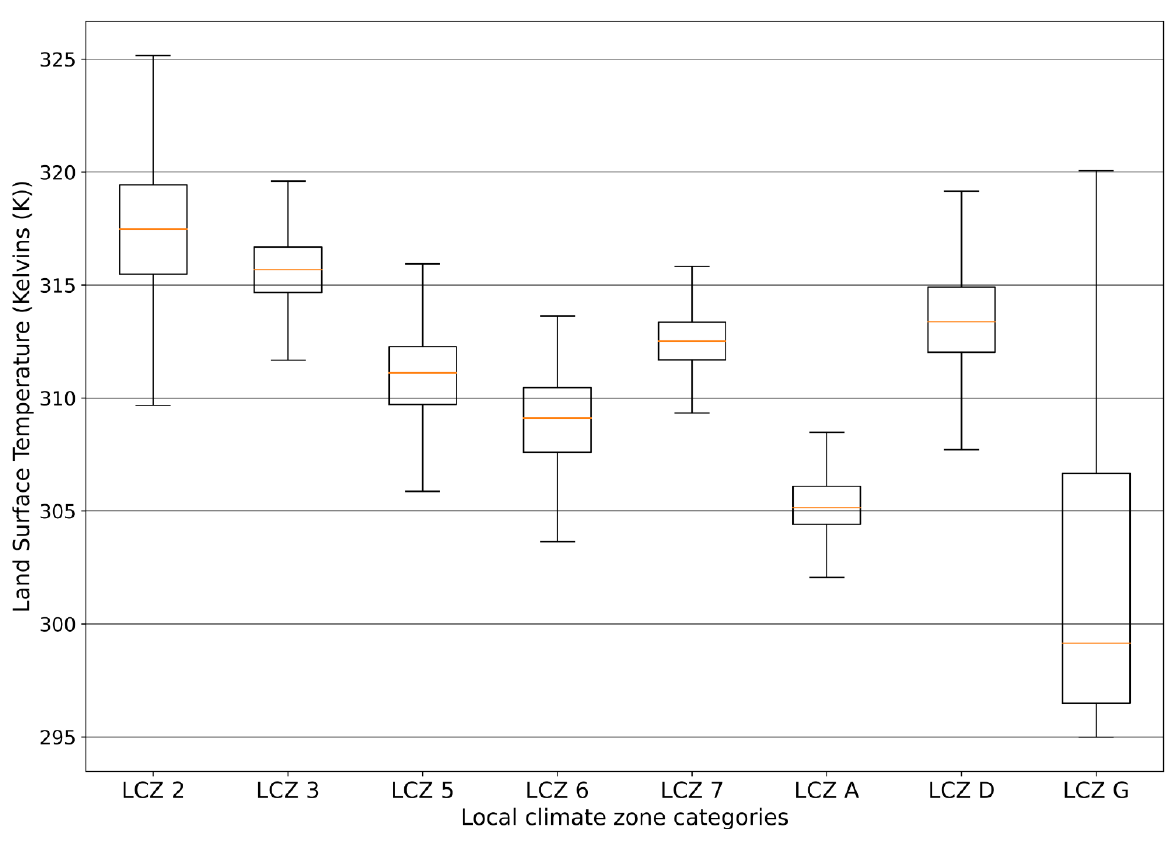
Figure 5. Variations of LST between and within